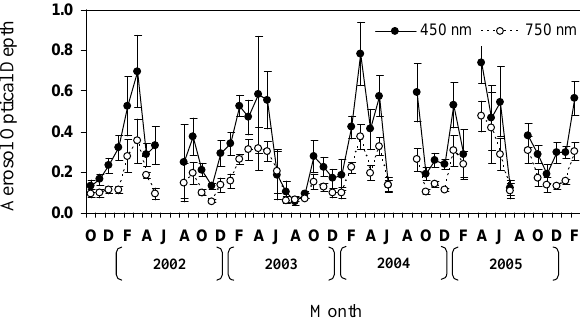
Fig. 3. Monthly variation of aerosol optical depth over Dibrugarh Figure 3 : Monthly variation of aerosol optical depth over Dibrugarh at 450 nm and 750 nm at 450nm and 750nm from October 2001 to February from October 2001 to February 2006